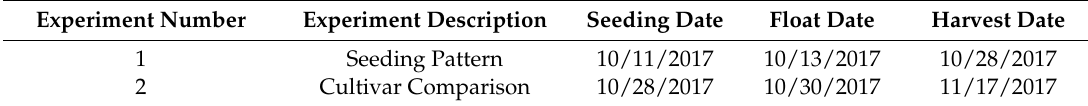
Table 1. Experiment descriptions and